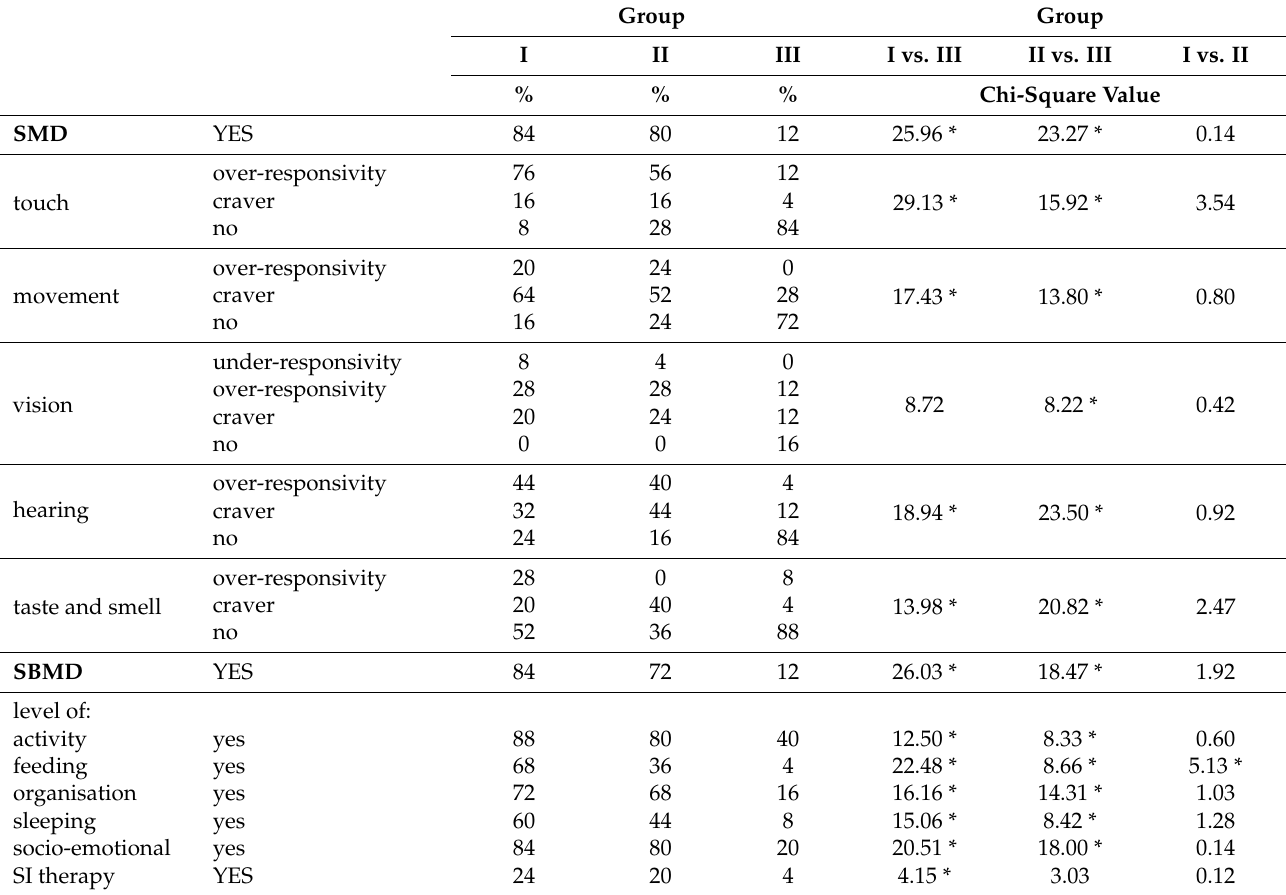
Table 2. Frequency of the Sensory Modulation Disorder in Groups I, II and